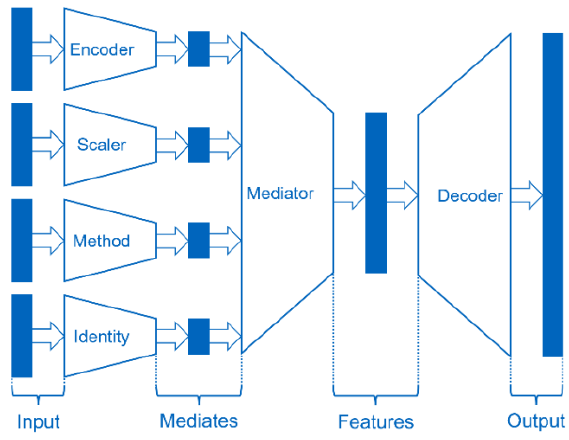
Figure 3. Basic concept of the FlexMod Framework fostering flexibility and standardization. Blue bars denote data or tensors not true to